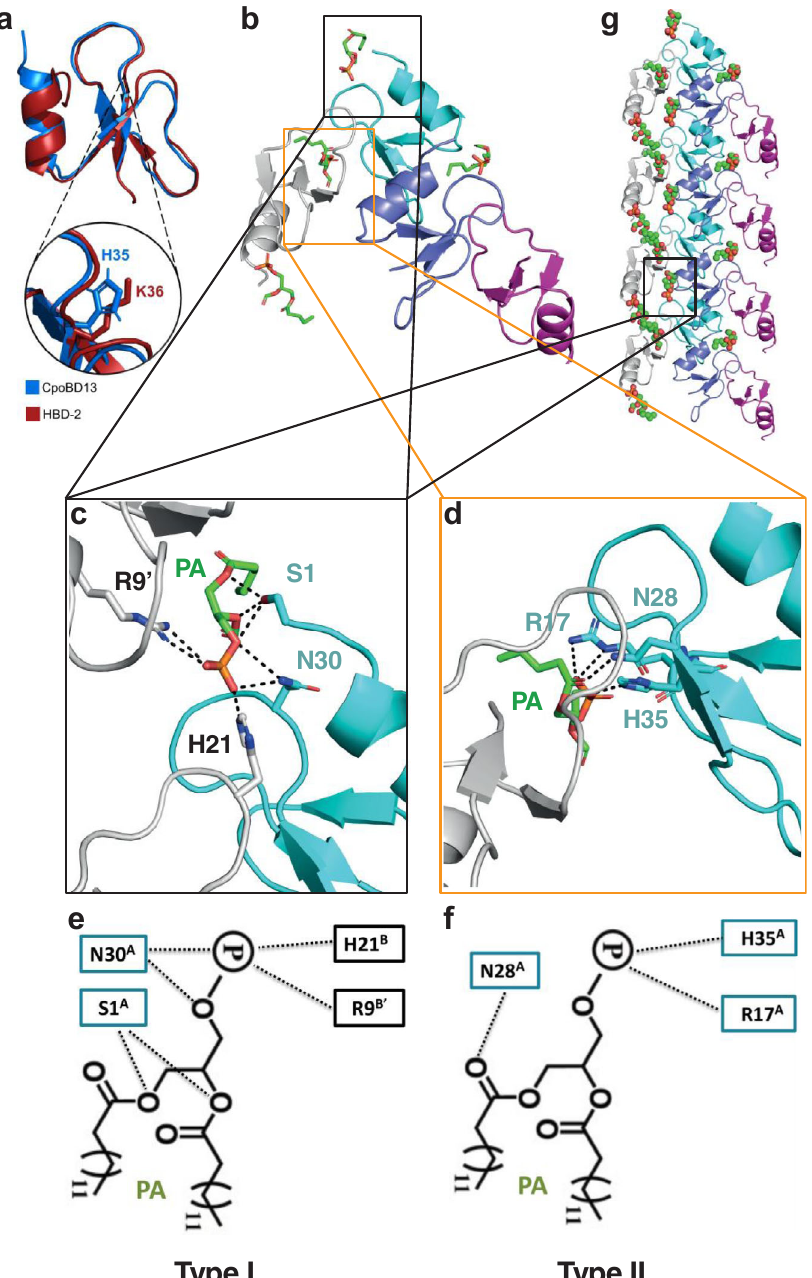
Fig. 3 | Crystal structure of the CpoBD13:PA complex. a Three-dimensional structure of CpoBD13 determined by X-ray crystallography superimposed with HBD-2 (PDB ID 1FD3). Zoomed in region shows the substitution of K36 (a crucial residue for membranolytic activity) inHBD-2 forH35 in CpoBD13. b Four CpoBD13 chains are found in the asymmetric unit (white, cyan, steel blue and magenta car- toon),bound to fourPAmoleculesshownasgreensticks. c TypeI and d Type II PA